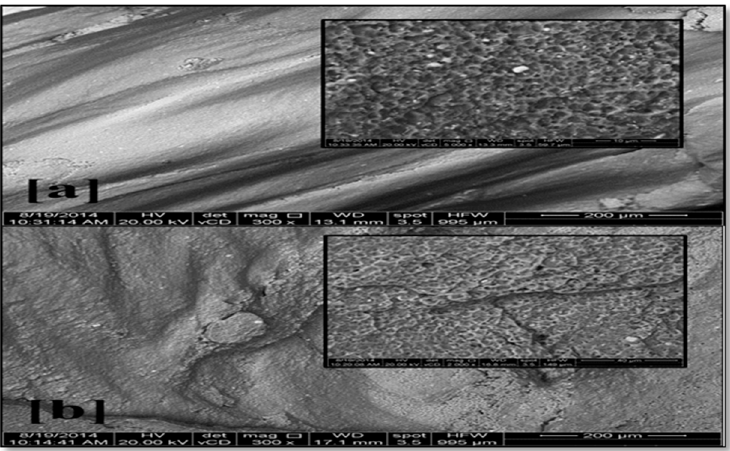
Figure 9. Photograph of the fractured ( a ) as-received and ( b ) friction stir-processed tensile specimens.